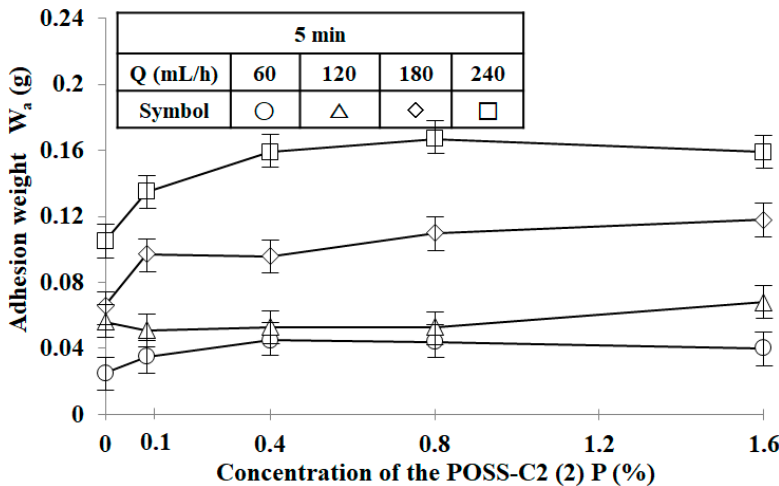
Figure 6. Relationship between W a and POSS-C2 (2) concentration.